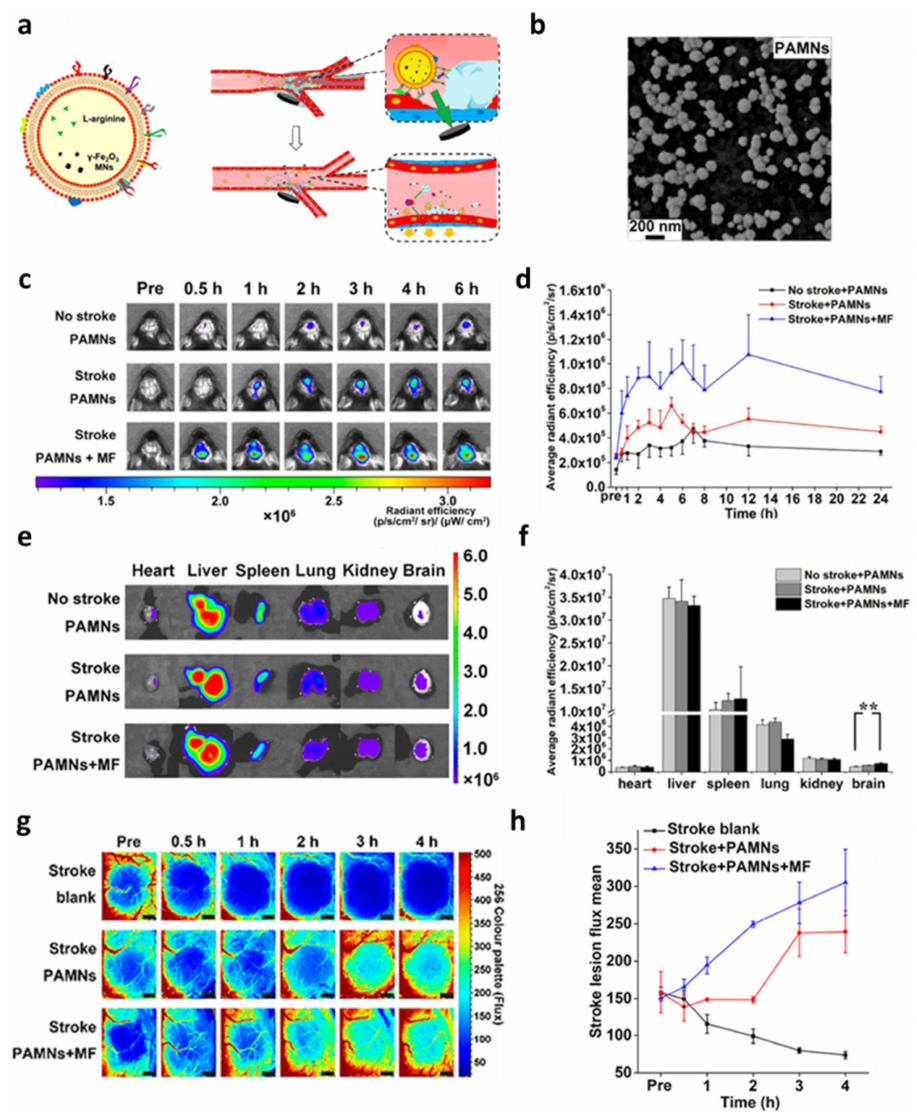
Figure 5. ( a ) Schematic representation of platelet membrane enclosed L-arginine and magnetite nanoparticles (PAMN) structure and in vivo targeting moieties. As PT membrane-coated